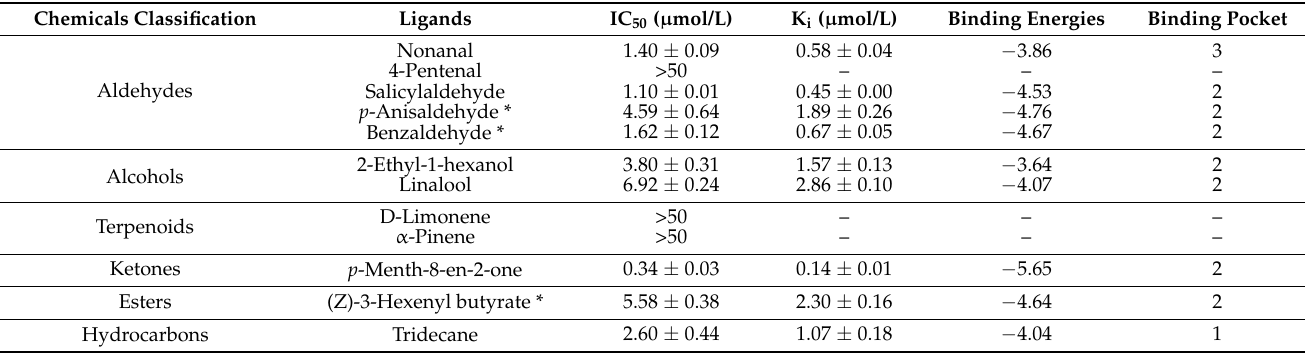
Table 3. Binding ability of recombinant O.lotOBP6 to ligands identified in host